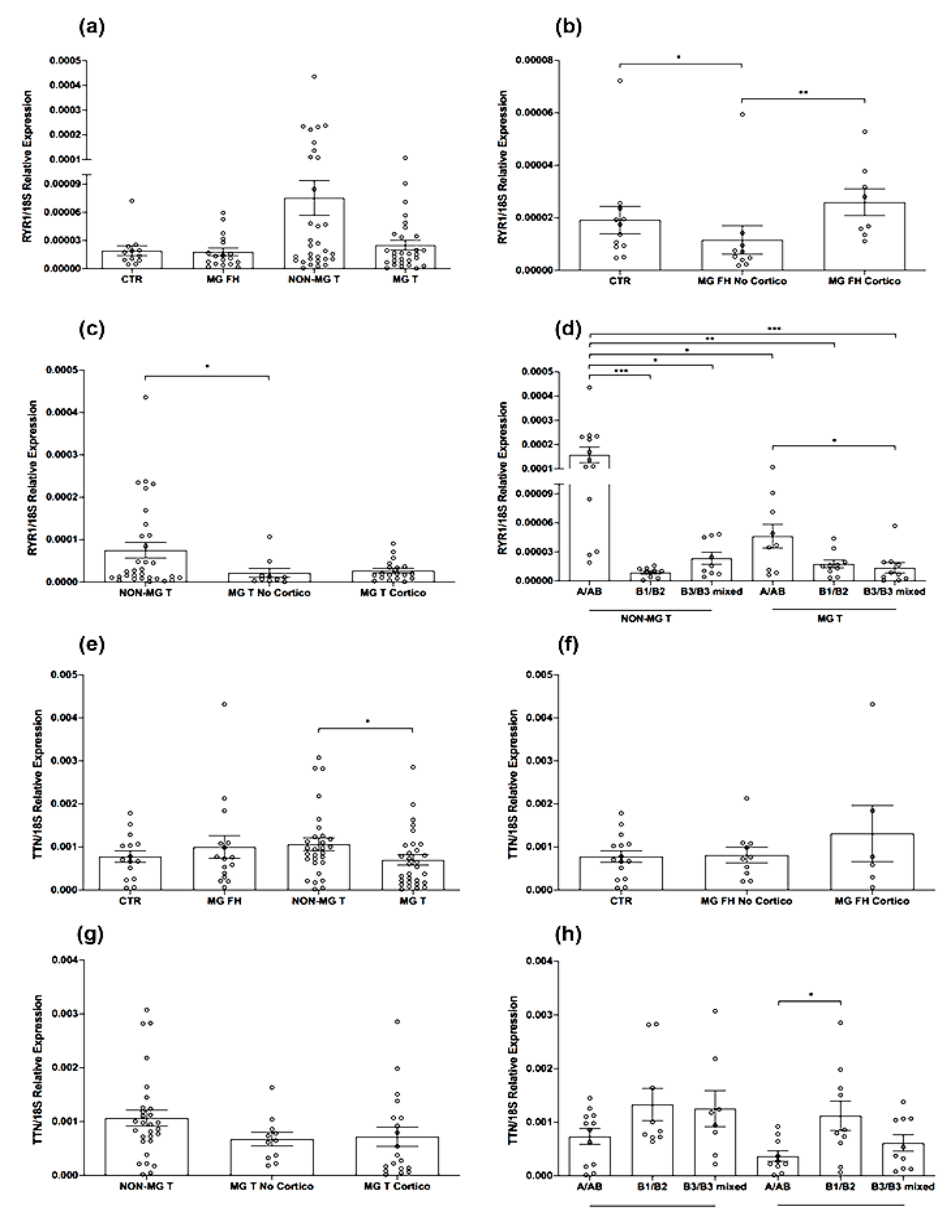
Figure 2. RYR1 and TTN expression in MG and control thymuses. ( a ) RYR1 mRNA levels in normal thymuses (CTR), follicular hyperplastic MG (MG FH) thymuses, thymomas from non-MG (NON-MG T), and MG (MG T) patients. ( b ) RYR1 mRNA levels in MG FH thymuses from corticosteroid-naïve (MG FH No Cortico) and -treated (MG FH Cortico) patients compared to CTR. ( c ) RYR1 mRNA levels in MG thymomas from corticosteroid-naïve (MG T No Cortico) and -treated (MG T Cortico) patients compared to NON-MG T. ( d ) RYR1 mRNA levels in NON-MG T and MG T stratified according with WHO thymoma type. ( e ) TTN mRNA levels in CTR, MG FH, NON-MG T, and MG T. ( f ) TTN mRNA levels in MG FH No Cortico and Cortico, compared to CTR. ( g ) TTN mRNA levels in MG T No Cortico and Cortico, compared to NON-MG T. ( h ) TTN mRNA levels in NON-MG T and MG T stratified according with WHO thymoma type. In the graphs, RYR1 and TTN expression levels were expressed as relative values (2 −Δ Ct × 100) normalized toward the endogenous 18S. Mann–Whitney test, * p < 0.05; ** p < 0.01; *** p < 0.001. The TTN mRNA levels were also significantly lower in MG than non-MG thymomas, We did not find any differences in the CHRNA1 , RYR1 , and TTN expression levels but not in hyperplastic MG compared to the control thymuses, with no differences between male and female patients, nor between normal thymuses from observed between the corticosteroid-naïve and -treated patients (Figure 2e–g). As